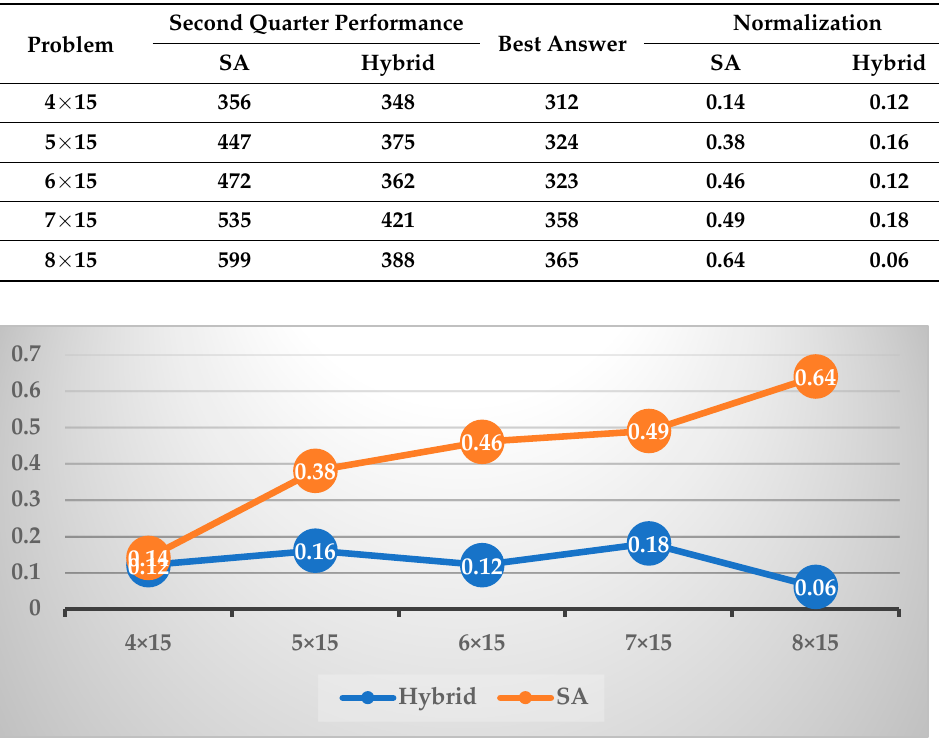
Figure 16. Fitness diagram of SA and hybrid SA in the second quarter (15 ORs). Table 7. Results of executing the SA and hybrid SA algorithms in the third quarter (10 ORs) .